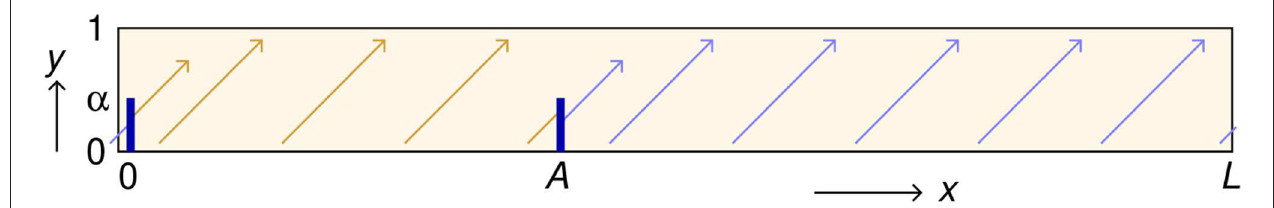
FIGURE 2 | The variables x (horizontal, period L 1) and the sieve variable y (vertical, period 1), together moving in the direction of the arrows. See text. ≫